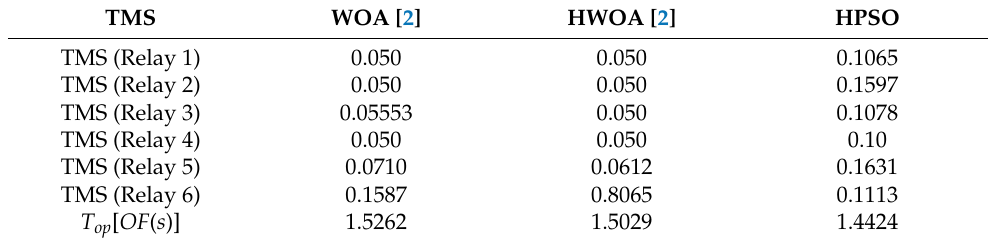
Table 16. Comparison of the optimized TMS with other techniques (case